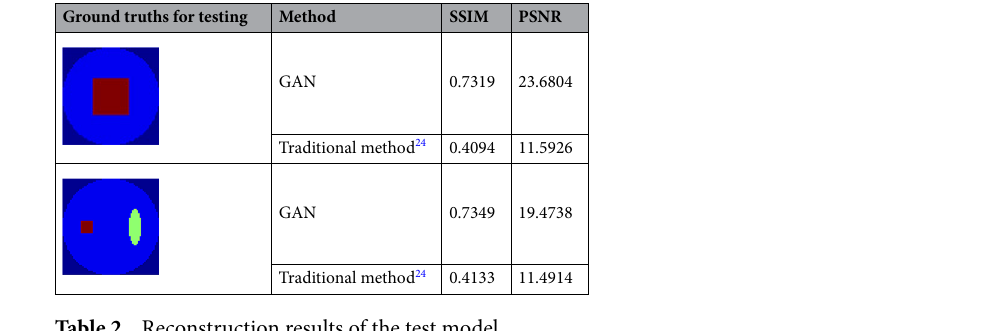
Table 2. Reconstruction results of the test model.